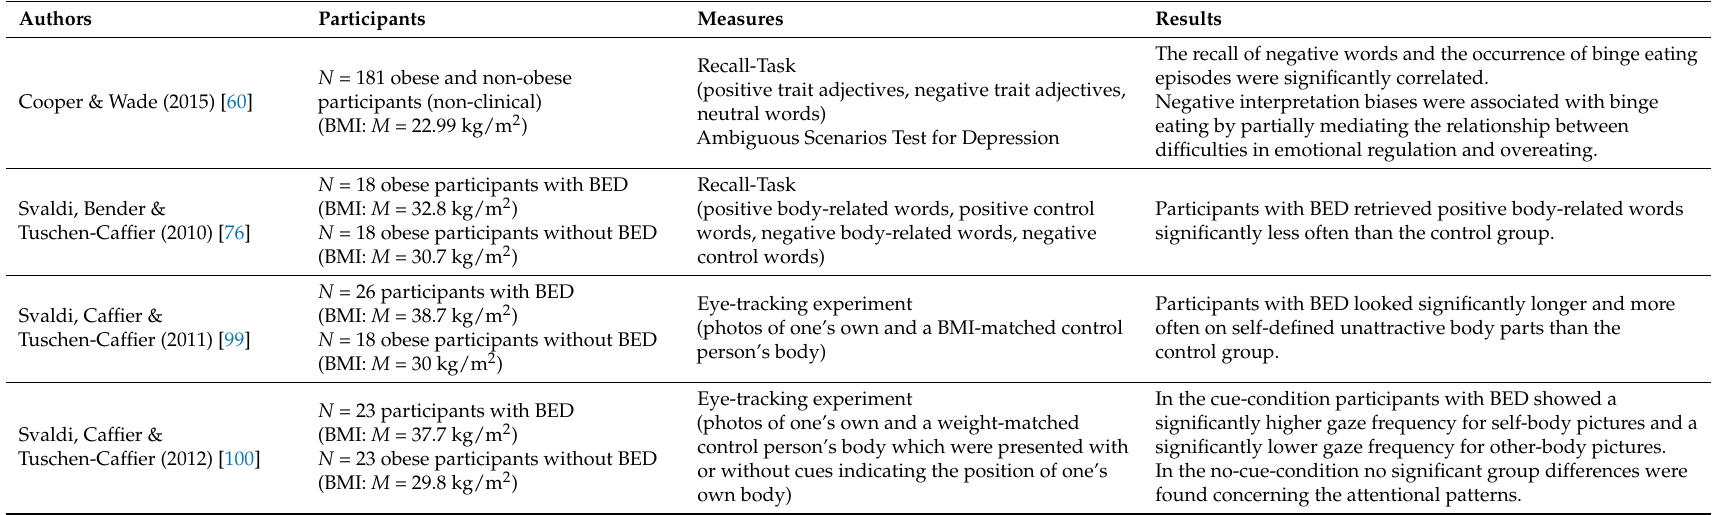
Table 5. Studies of body-related cognitive